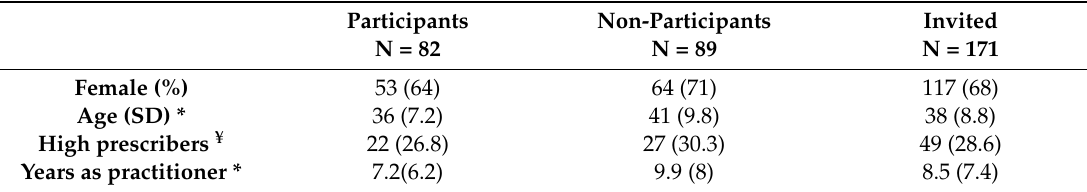
Table 1. Baseline characteristics of the invited General Practitioners